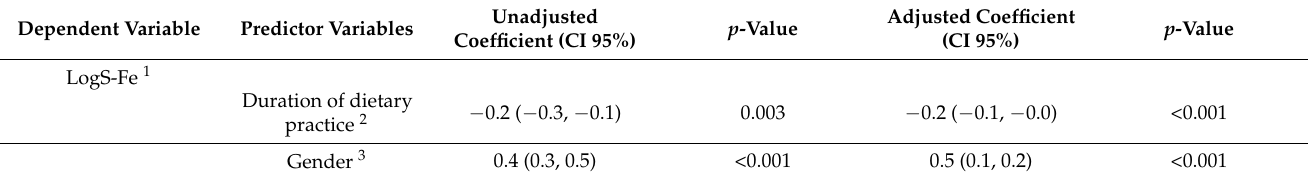
Table 4. Predictors of serum-ferritin concentration in vegans, vegetarians and pescatarians ( n = 191). Unadjusted Adjusted Coefficient p -Value p -Value Dependent Variable Predictor Variables Coefficient (CI 95%) (CI 95%) LogS-Fe 1 Duration of dietary − 0.2 ( − 0.3, − 0.1) 0.003 − 0.2 ( − 0.1, − 0.0) <0.001 practice 2 Gender 3 0.4 (0.3, 0.5) <0.001 0.5 (0.1, 0.2)